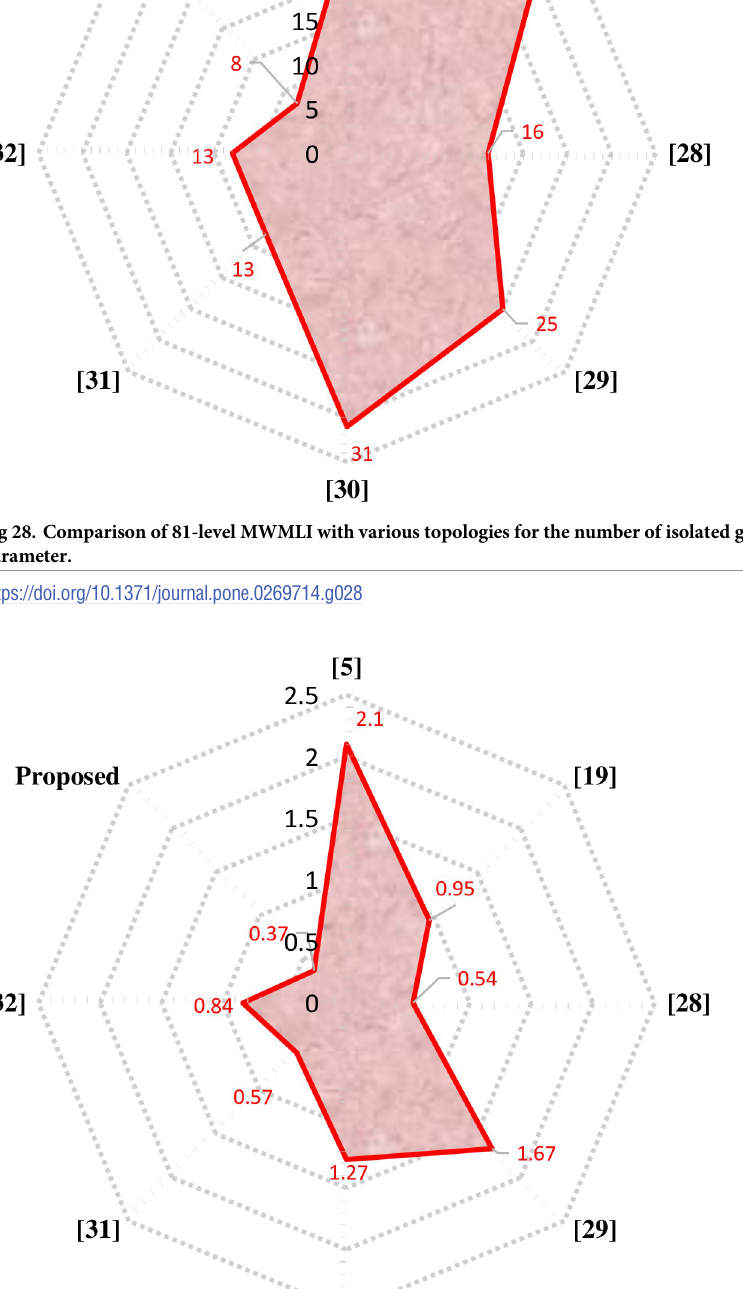
PLOS ONE | https://doi.org/10.1371/journal.pone.0269714 June 22,